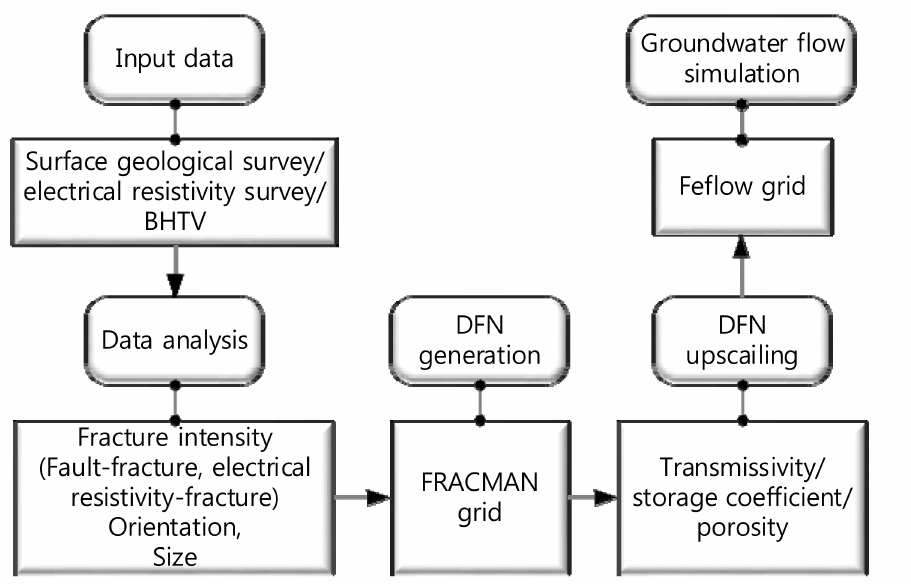
Figure 1. Workflow to build hydraulic properties of fractured rocks incorporating discrete fracture network (DFN) generation and